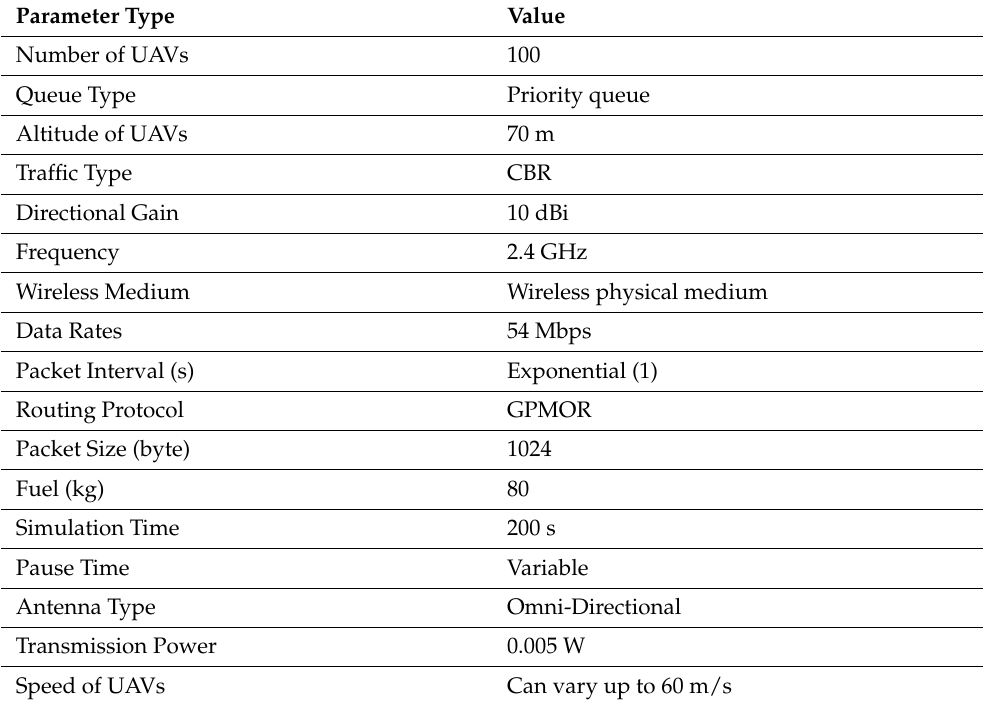
Table 3. Dimensions of UAVs in the